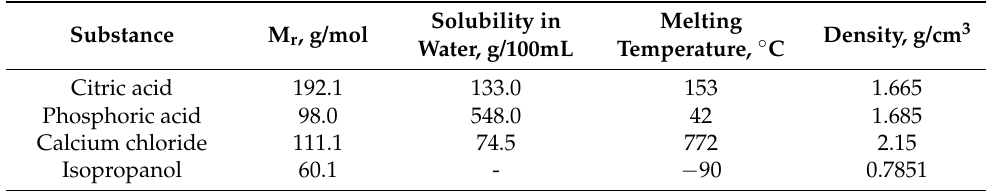
Table 1. The properties of